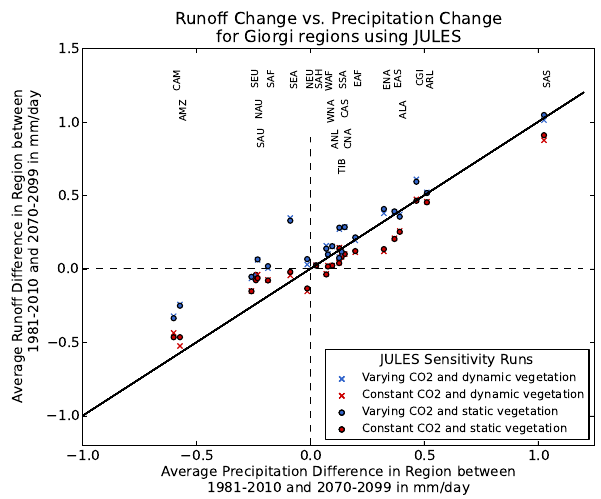
Fig. 7. Scatter plot of precipitation change against runoff change between 1981-2010 and 2070-2099 in mm day-1 for the Giorgi regions – forthefourJULESsimulationsforcedwithHadGEM2-ESRCP8.5climate. Solid1:1line. Dashedx=0lineandy=0line.